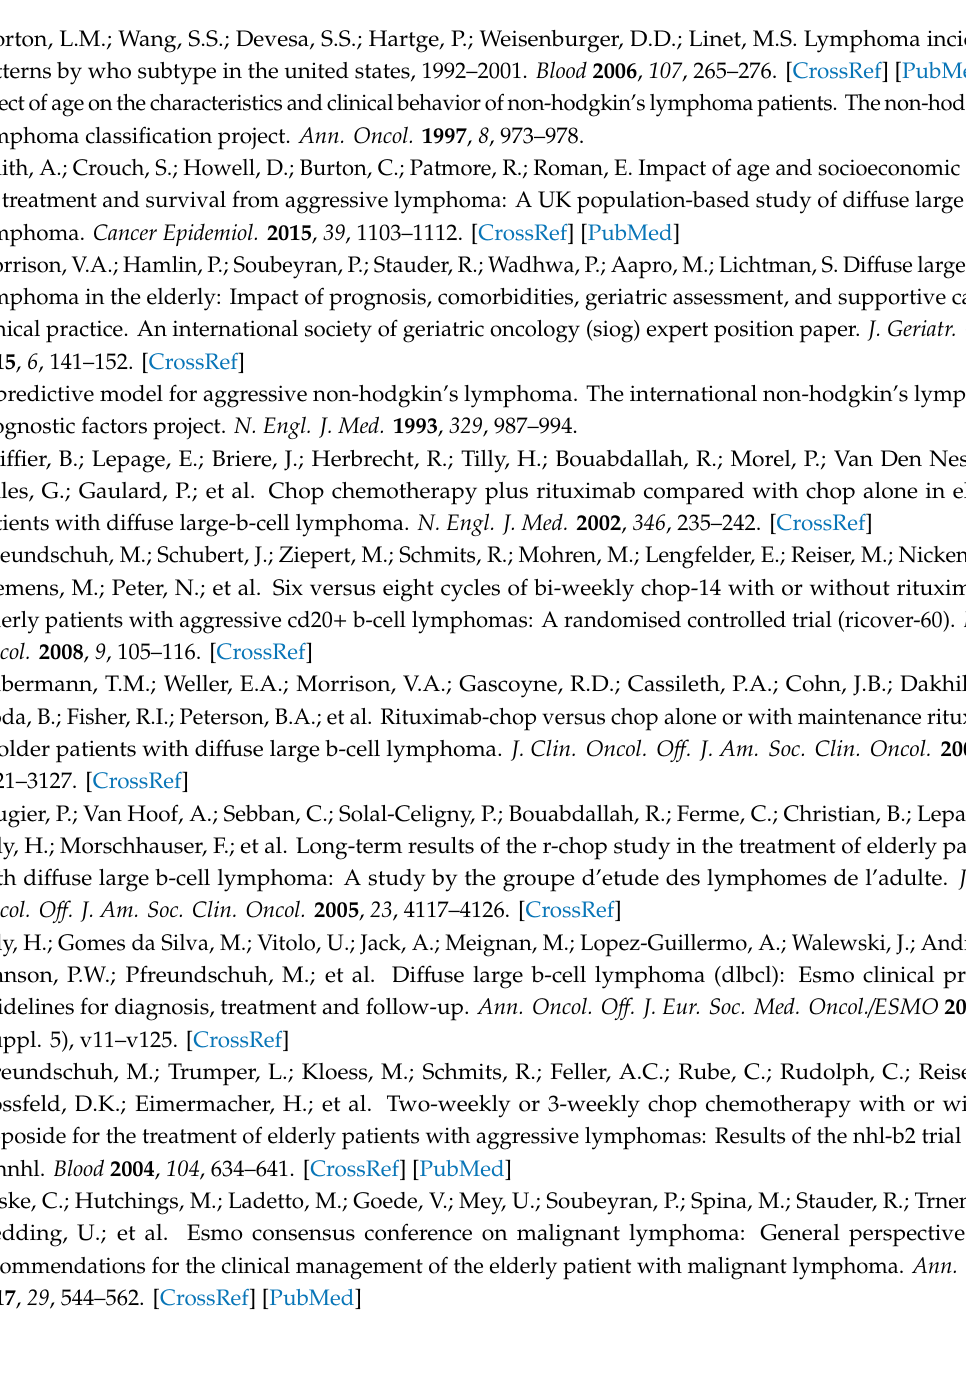
Table S1: Clinical response compared to comorbidity scoring, Table S2: Prognostic factors for overall survival in multivariate analyses using the Charlson